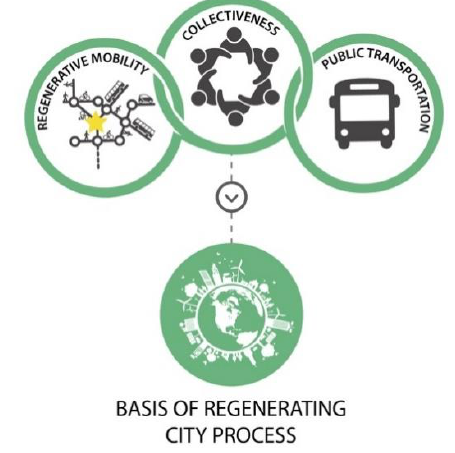
Figure 3 The basis of regenerating city process. Source: